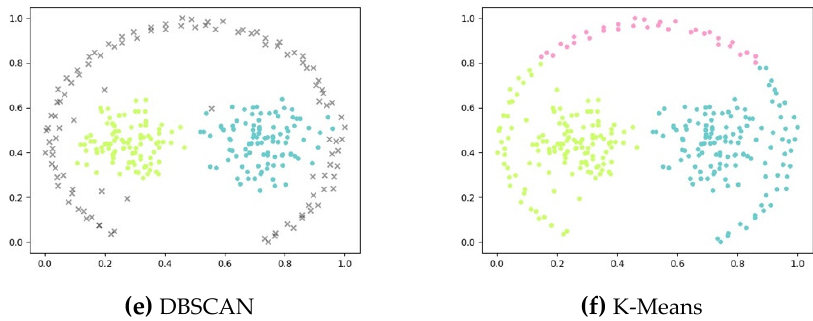
Figure 6. Clustering results on the Pathbased dataset.